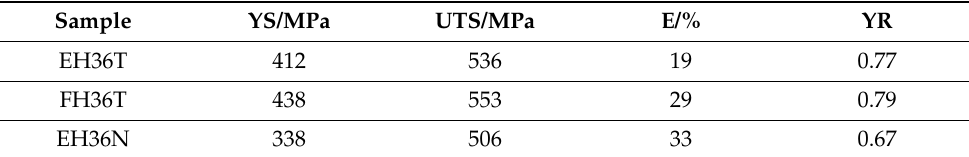
Figure 8. Mechanical properties and corresponding fractographs of rolled plate samples: ( a ) stress – strain curves; ( b ) me- chanical properties; and ( c – e ) SEM fractographs of the plates of EH36T, FH36T, and EH36N. Table 3. Mechanical